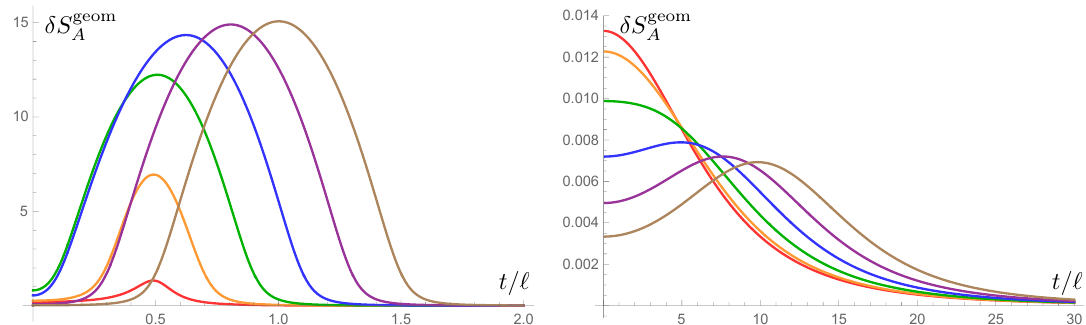
Figure 8 . Time evolution of the geometric correction to entanglement entropy (cid:14)S A for non-centered intervals. All plots correspond to a quench by an operator with (cid:1) = 2. In the left panel we (cid:12)xed (cid:11)=‘ = 10 (cid:0) 1 and pick x c =‘ = 0 ; 1 = 5 ; 2 = 5 ; 3 = 5 ; 4 = 5 ; 1 corresponding to the red, orange, green, blue, purple and brown curves, respectively. In the right panel we (cid:12)xed (cid:11)=‘ = 10 and pick x c =‘ = 0 ; 2 ; 4 ; 6 ; 8 ; 10 corresponding to the red, orange, green, blue, purple and brown curves,